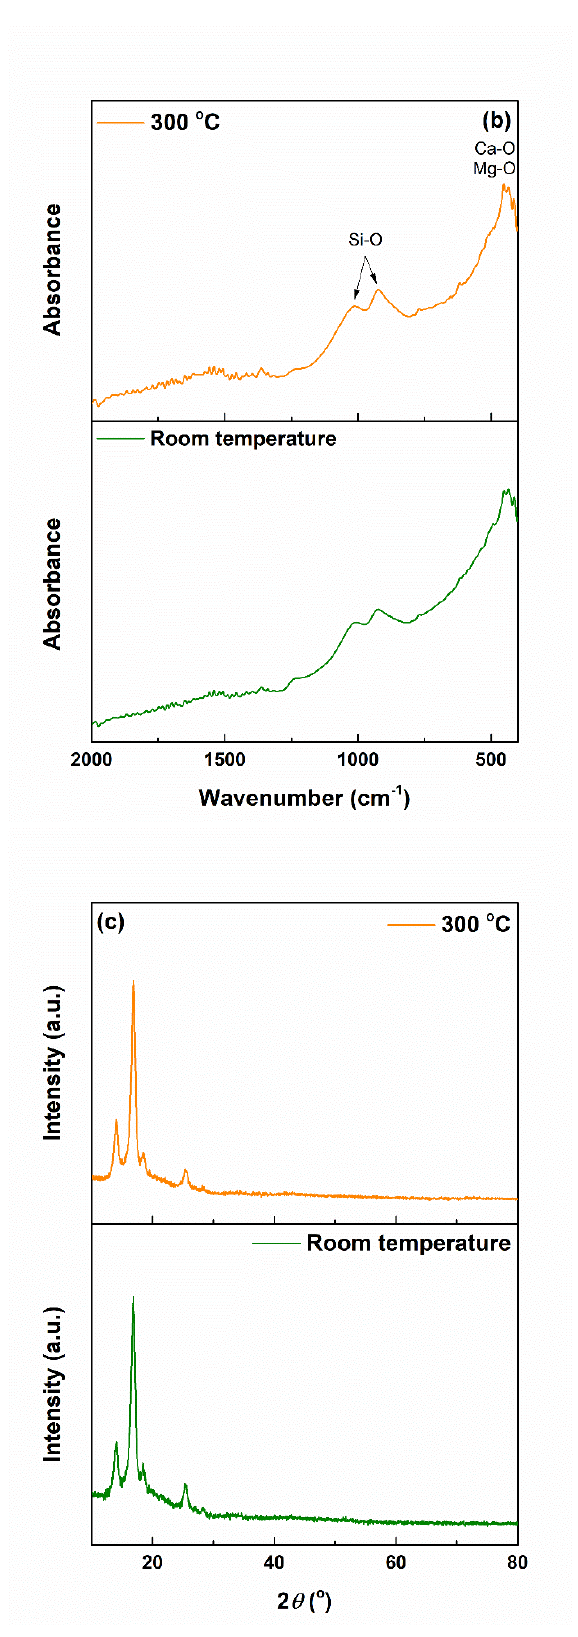
Figure 5. ( a ) EDX spectra, ( b ) FTIR spectra, and ( c ) XRD patterns of the coatings.